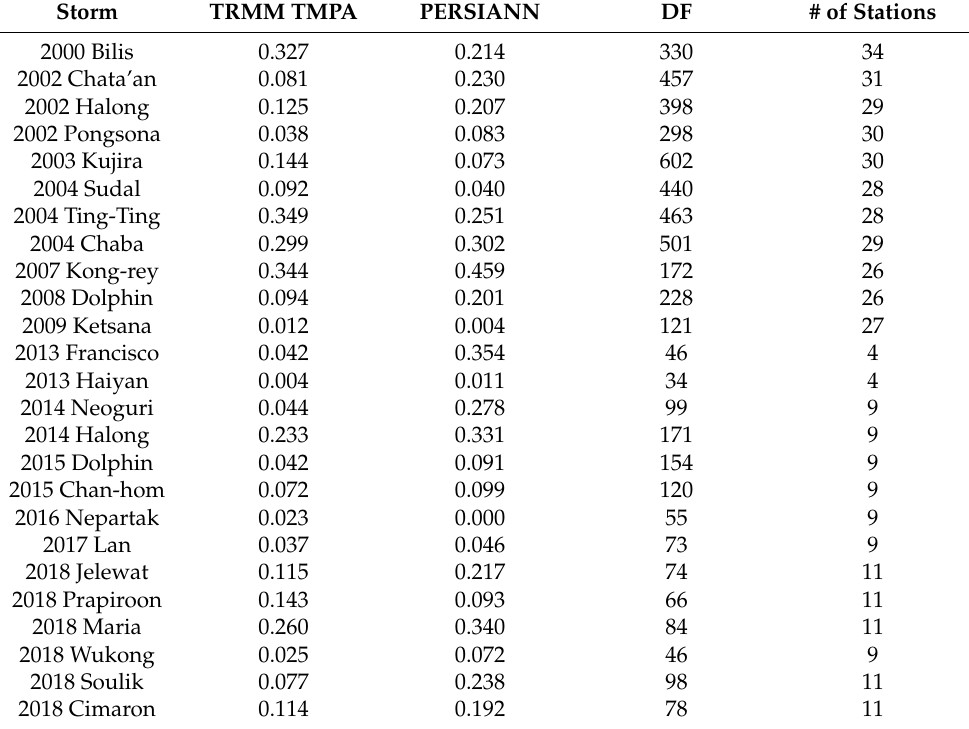
Figure 8. Cumulative precipitation values from PERSIANN, TRMM TMPA, and in situ gauges for the 2002 Typhoon Chataan. Table 4. R-square values, degree of freedom, and number of stations for each typhoon for TRMM TMPA and